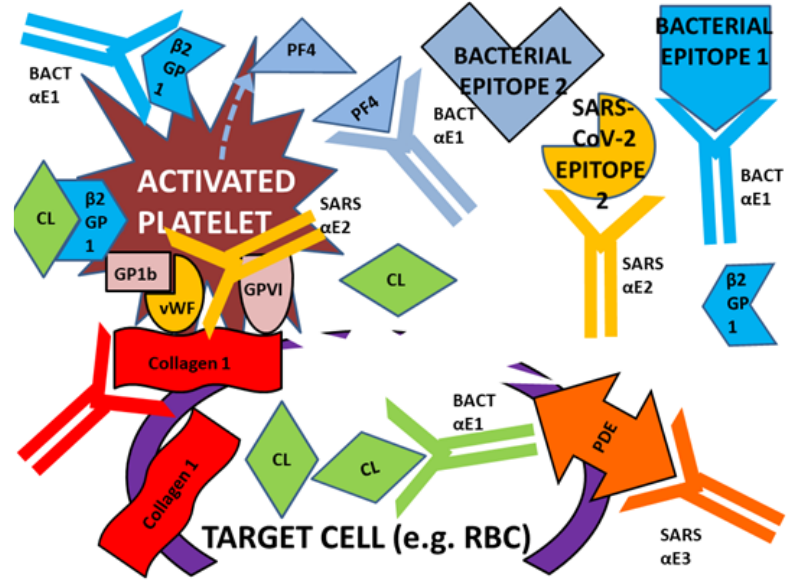
Figure 20. Simplified illustration of the many possible cross-reactive antibody targets that may result from epitope similarities shared by bacterial, viral and blood proteins. See Figure 20 for further information about the initiation of some of these reactions and Figure 16 for abbreviations.